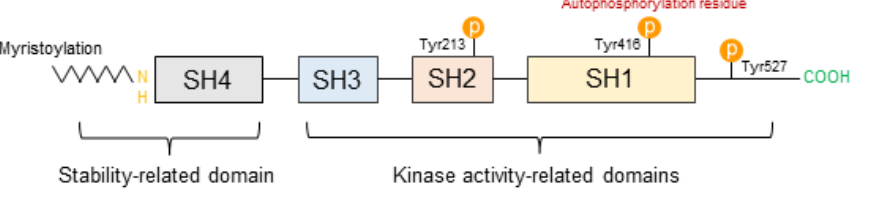
Figure 1. Structure of